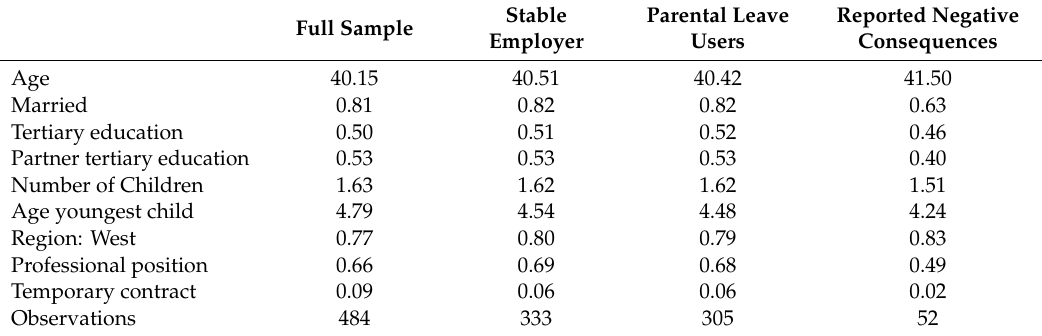
Table A3. Summary statistics for women (full sample), women with a stable employer, women who took parental leave, and women who reported negative consequences. Women who were unemployed or not employed at the time of the interview were excluded.